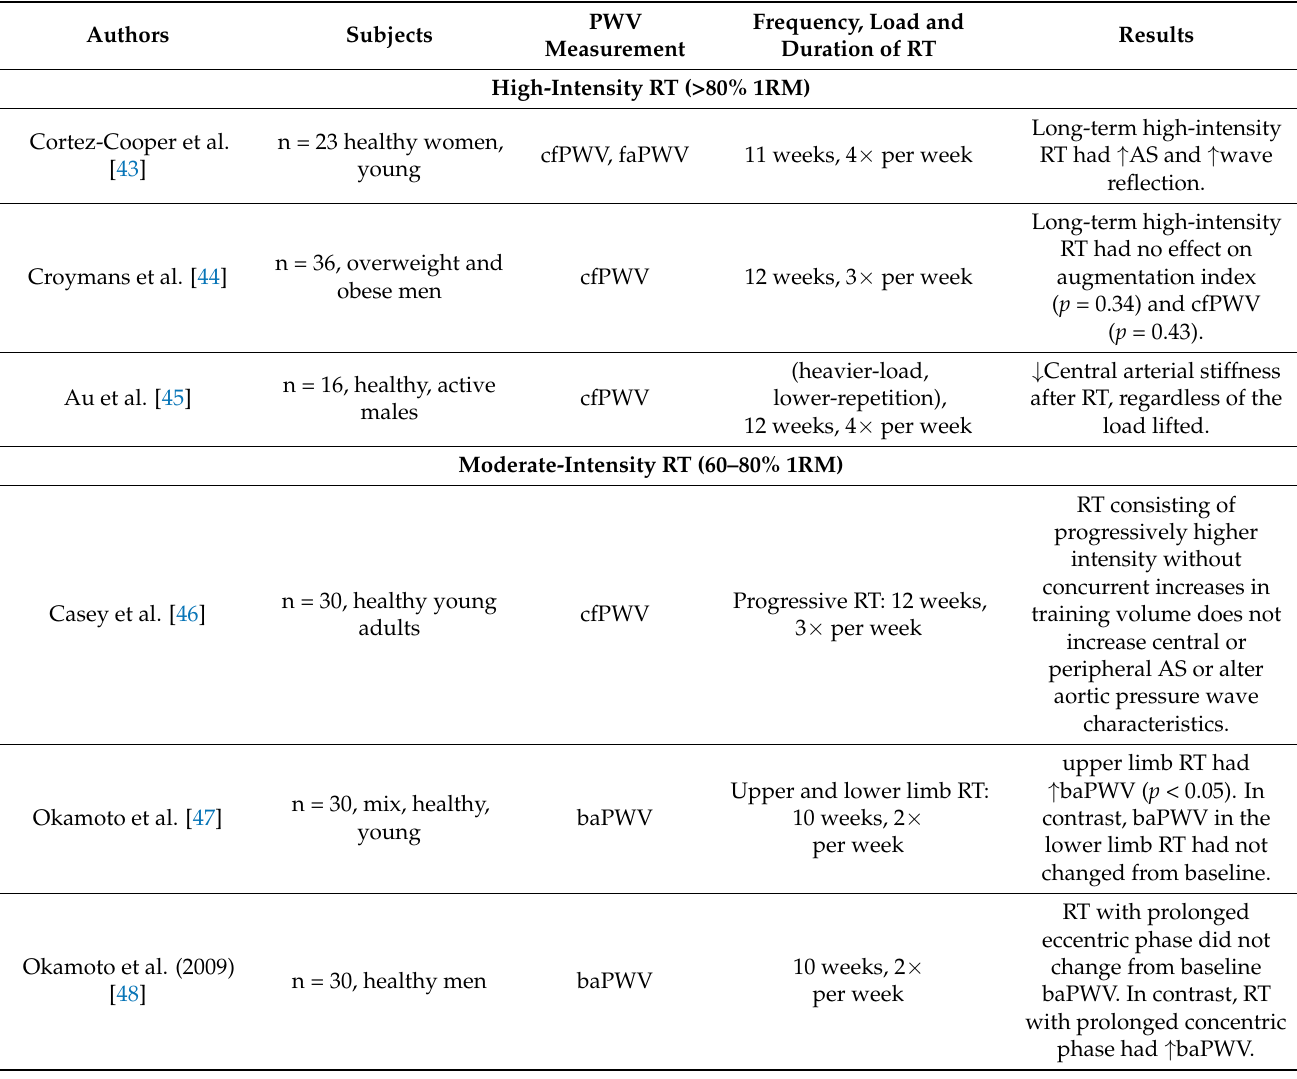
Table 2. Changes in arterial stiffness and pulse wave velocity as a result of a long-term resistance training program.